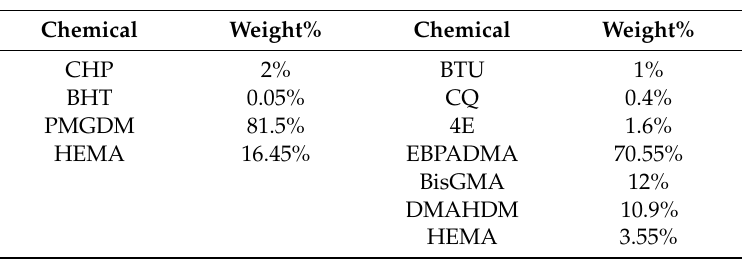
Table 3. Chemical composition of PEHB monomers with 3%